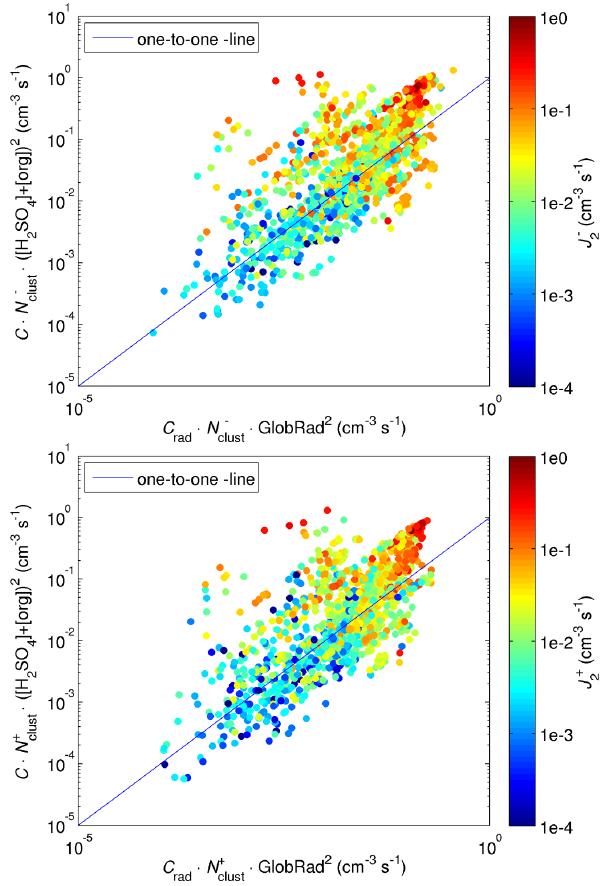
Fig. 5. Comparison of the ion-induced nucleation rate parameter- izations of Eqs. (3) and (6) for (a) negative and (b) positive ions based on the data set from Hohenpeissenberg, Melpitz and San Pietro Capofiume. The color of the data points indicates the ob- served J 2 value. The values for the fitting coefficients C are those given in Table